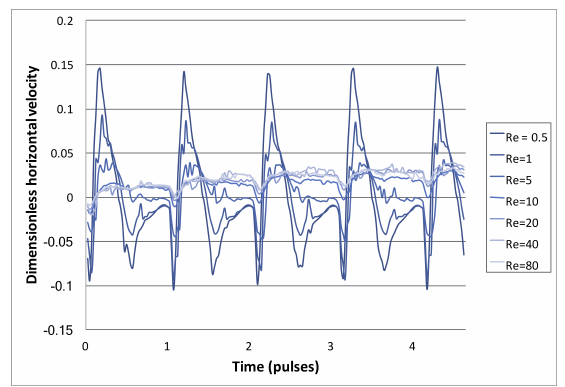
Fig. 9: The spatially averaged dimensionless hor- izontal flow towards the polyp ( u x ) over time during five pulse cycles. Re f = 0 . 5 , 1 , 5 , 10 , 20 , 40 , and 80 are shown. Velocity is given as tentacle lengths per